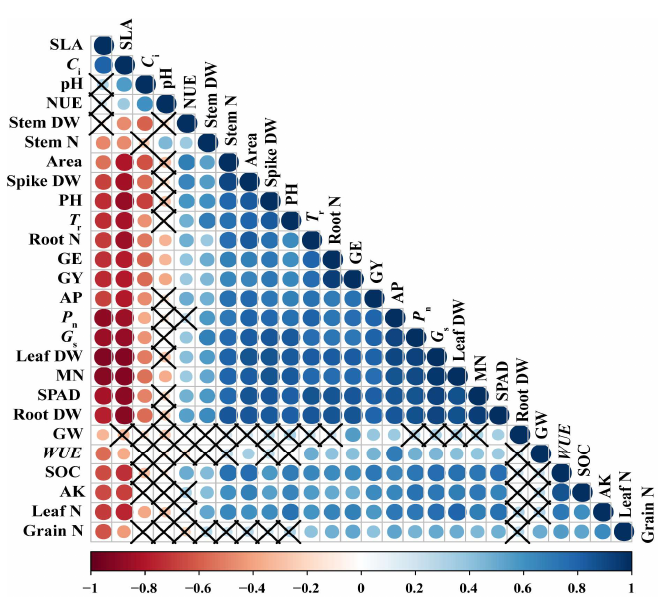
Figure 5. Heatmap based on the Spearman correlation matrix of different plant and soil parameters with different P nitrogen fertilizer and biochar treatments. AK—available potassium content, AP—